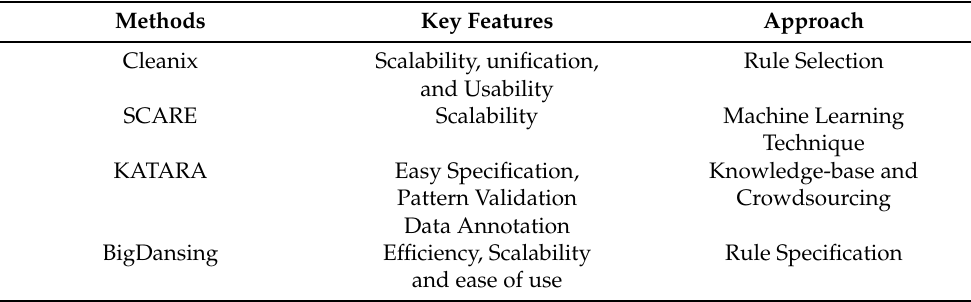
Table 1. Data-cleansing methods for big data.